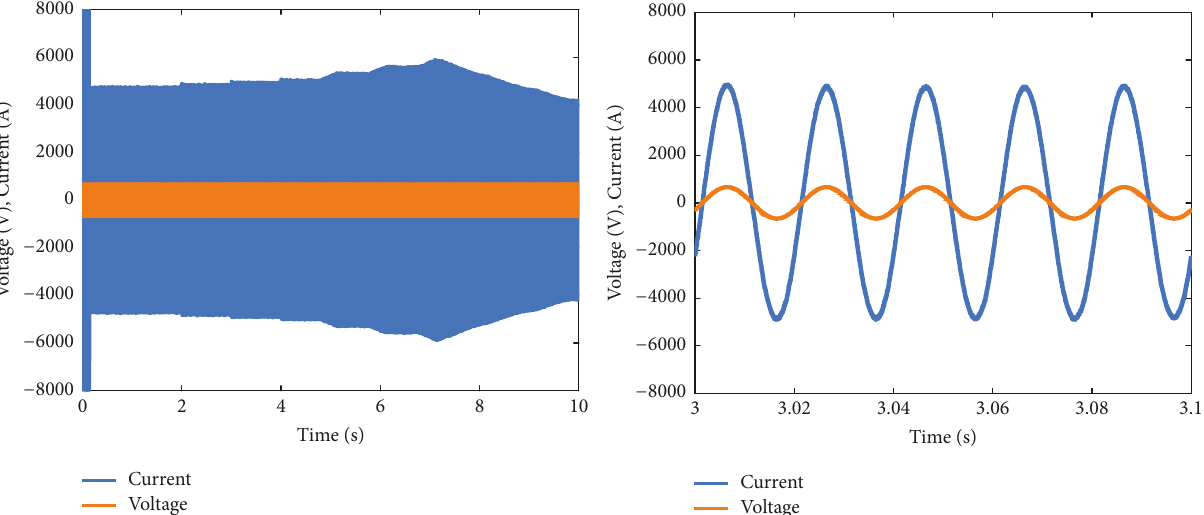
Figure 11: Simulation of the three-phase current and voltage of electrical network.